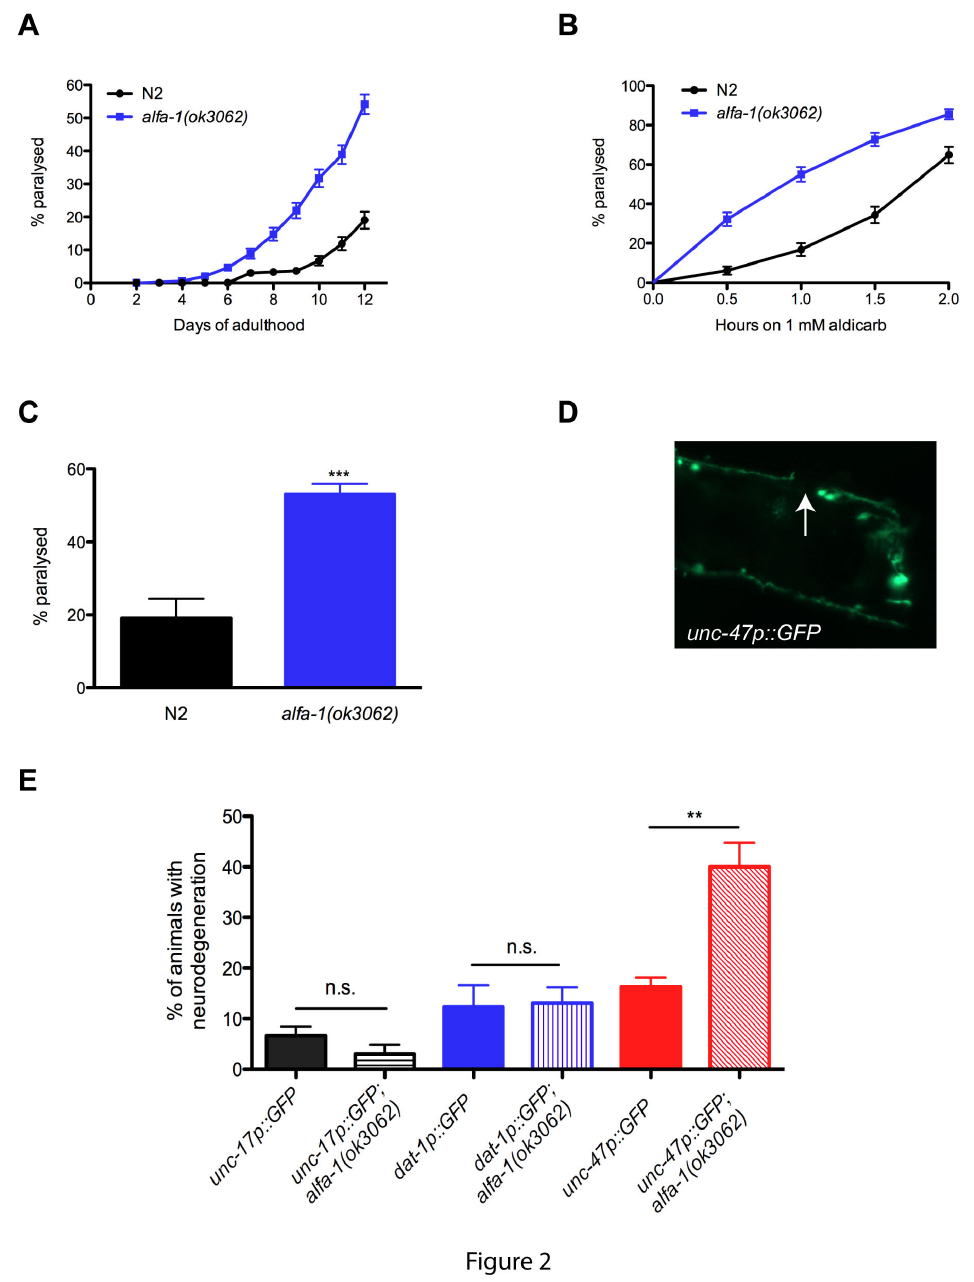
Figure 2. Age-dependent motility defects and neurodegeneration in alfa-1(ok3062) mutants. (A) alfa-1(ok3062) mutants showed motility defects leading to paralysis of 60% of the population by day 12 of adulthood compared to 20% for N2 worms (P<0.0001).